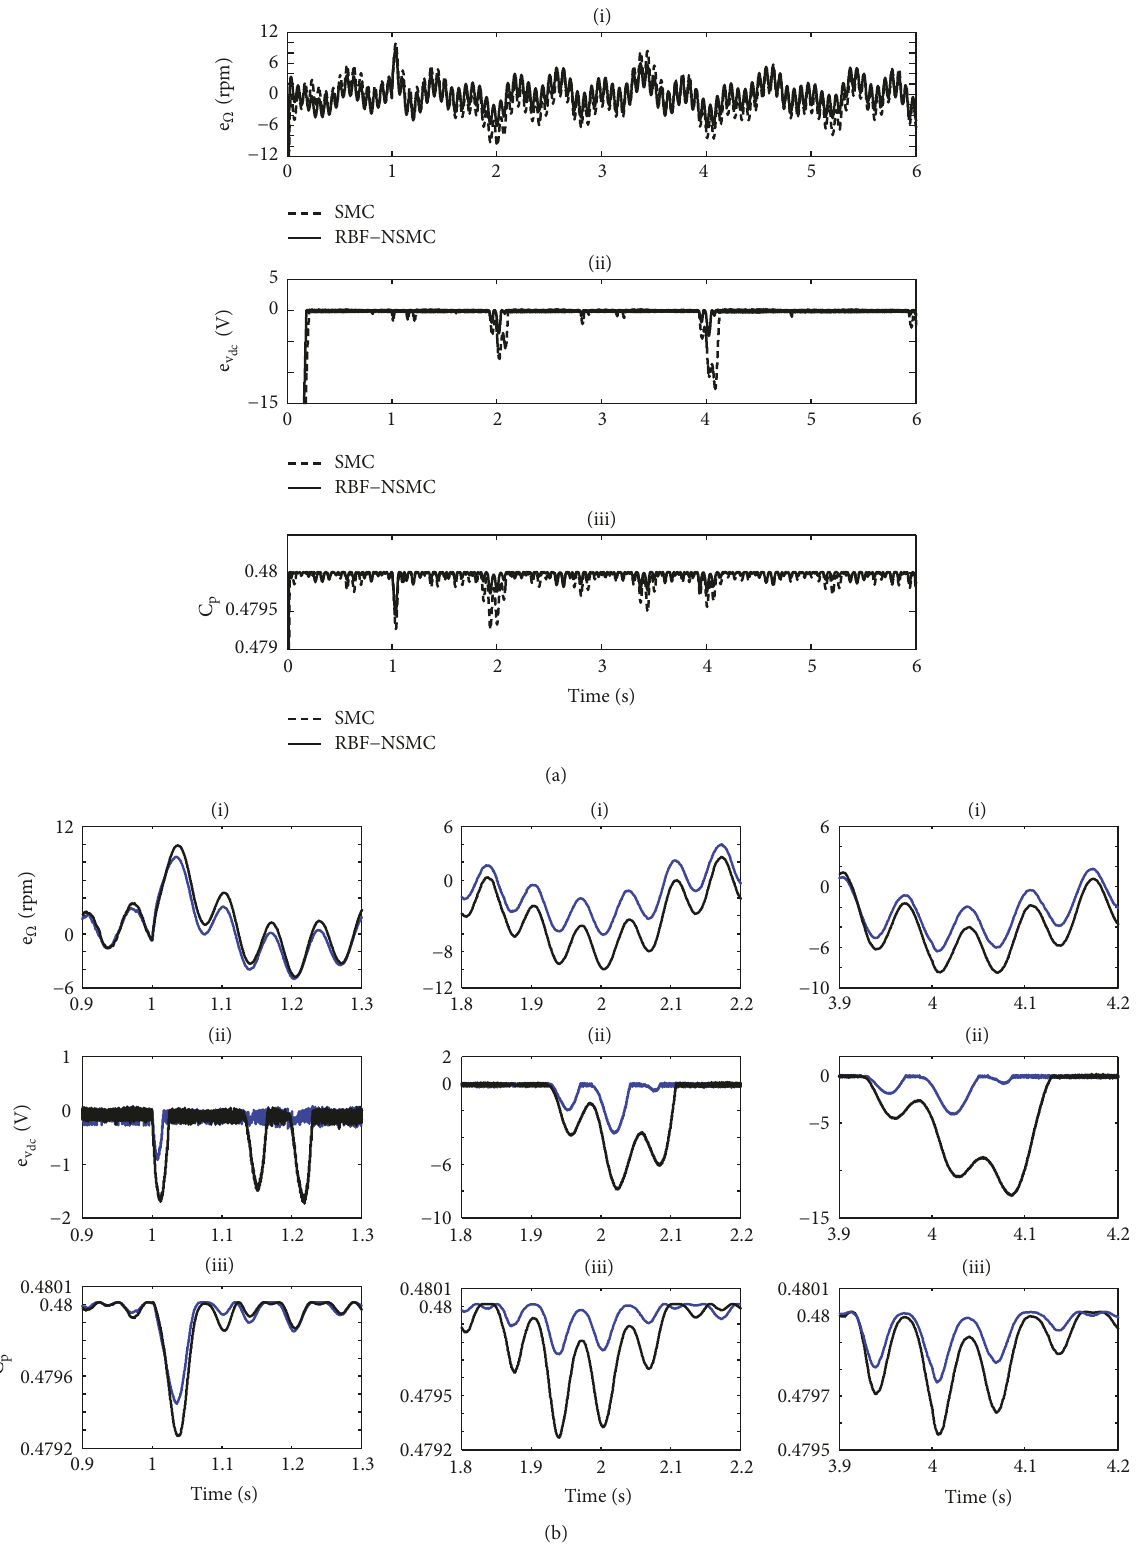
Figure 10: Control system response to wind speed fluctuations with parameters uncertainties (at time 𝑡 = 1𝑠 , variations of +100 % for 𝑅 𝑠 , +50 % for 𝐿 −20 % for 𝜙 +30 % for 𝐽 are introduced). (a) Signals trajectories and (b) corresponding zoom (blue line: RBF-NSMC, black 𝑠 , 𝑟 , and line: SMC). (i) Generator speed error, (ii) dc-link voltage error, and (iii) power